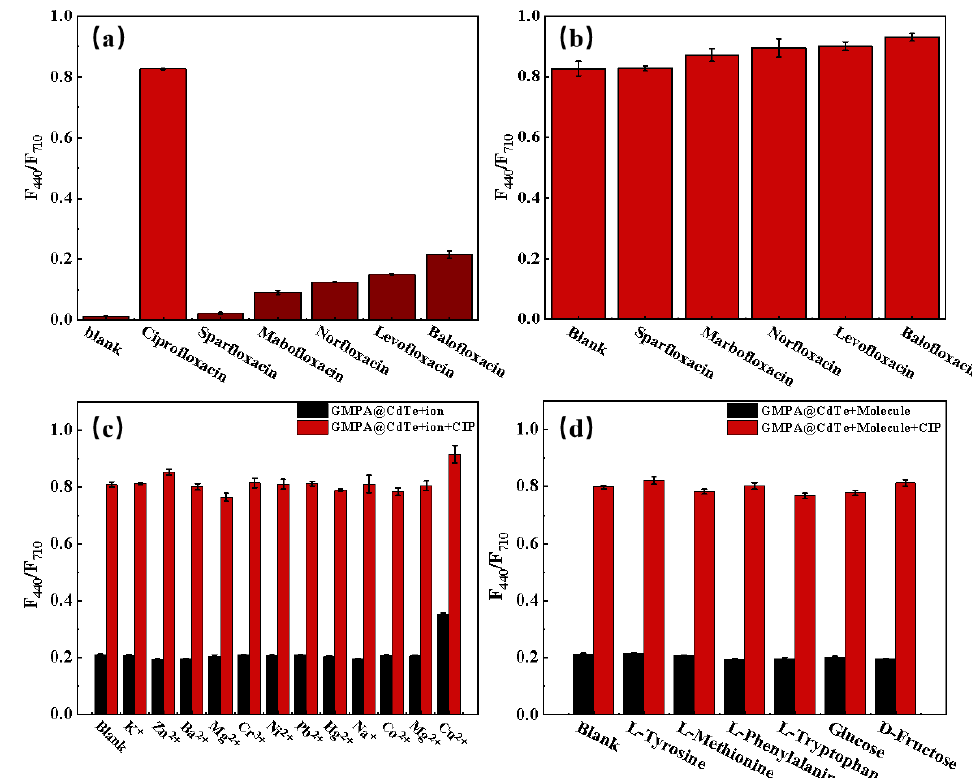
Figure 5. Selective characterization of RFFS/GMPA@CdTe-QDs sensor to CIP: ( a ) F 440 /F 710 ratio of sensor to different solution of CIP analogues (45 μM); ( b ) F 440 /F 710 ratio of sensor to the mixed solution of CIP and its different analogues (1:1); and the F 440 /F 710 responses of different ( c ) metal ions (1:10) and ( d ) molecules (1:10) before and after mixing with CIP.